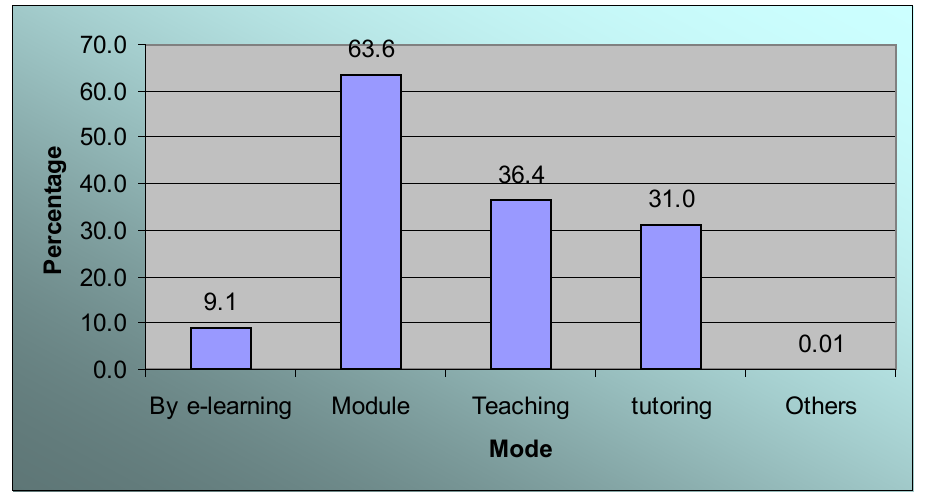
Figure 6 . Mode of receiving ILS